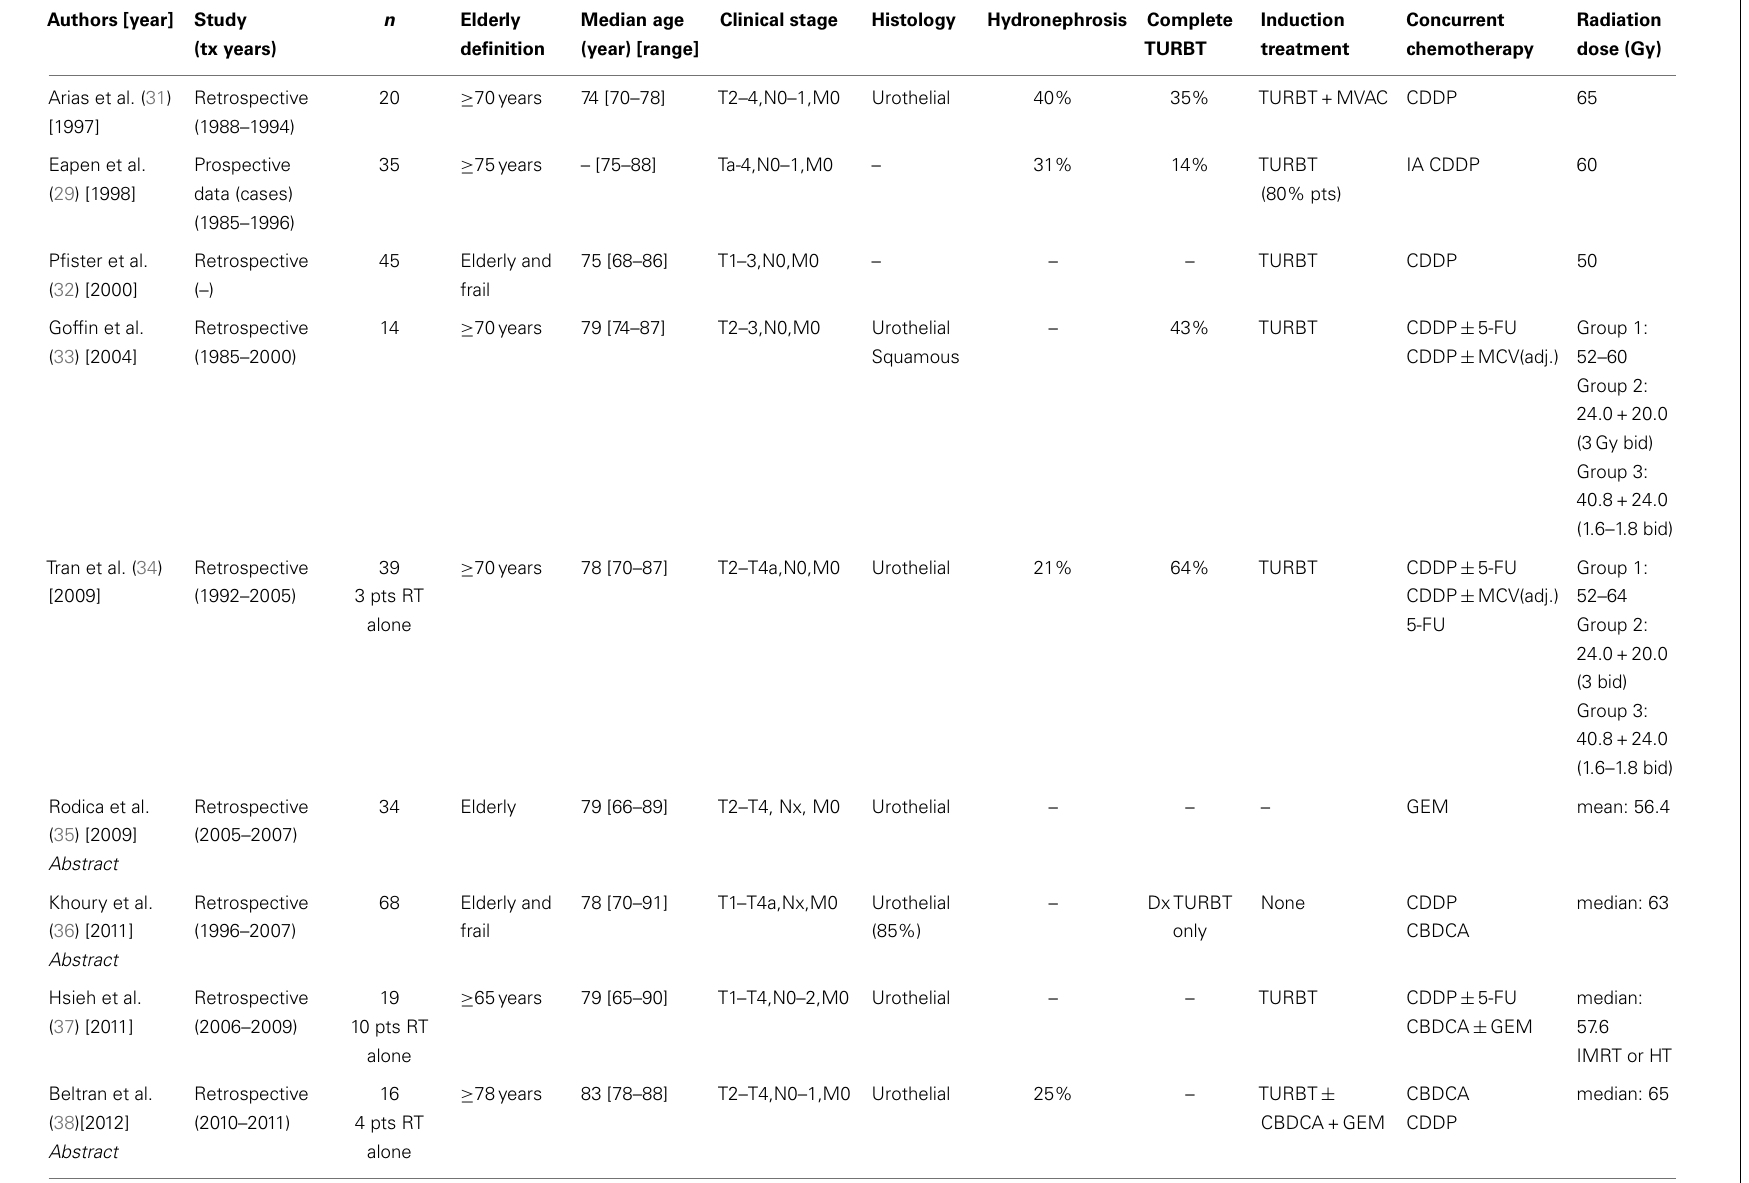
Table 1 | Patient demographics and treatment parameters